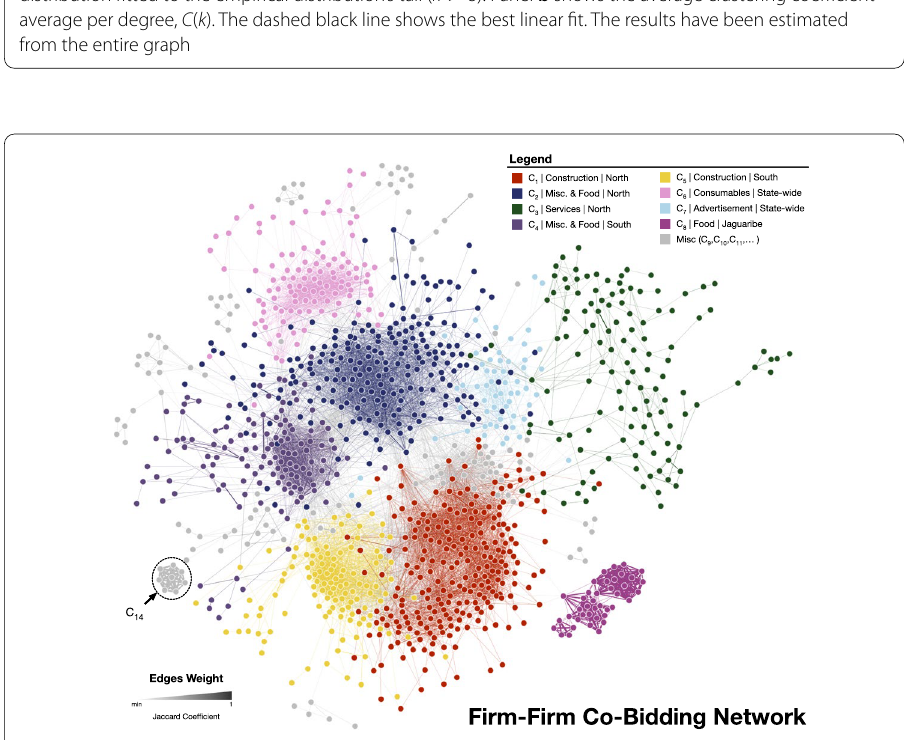
Fig. 3 Graphical representation of the Firm–Firm network, which relates firms with similar bidding patterns. In order to build the network, we only considered the most active firms and edges with a significant Jaccard similarity index. Represented is the giant component with some relevant disconnected components. Nodes in the giant component are colored according to one of the eight major communities (out of 22) identified using the Louvain algorithm (Blondel et al. 2008). The presented partition of the network achieved a modularity of 0.61. North and South categorization of the firms location was used here in a broader sense and should not be confused with the Mesoregions, which we identified with their Portuguese names. For reference, the North includes the Mesoregions of Norte and Noroeste; while the South includes Sul and Centro